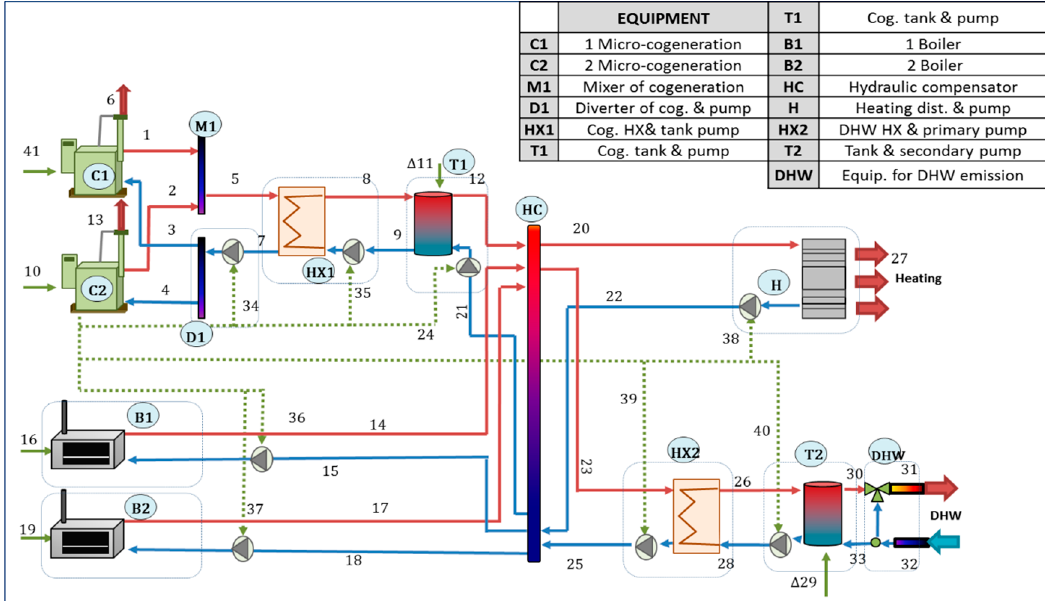
Figure 4. Schematic of the installation with numbering of flows, labelling of components and legend.